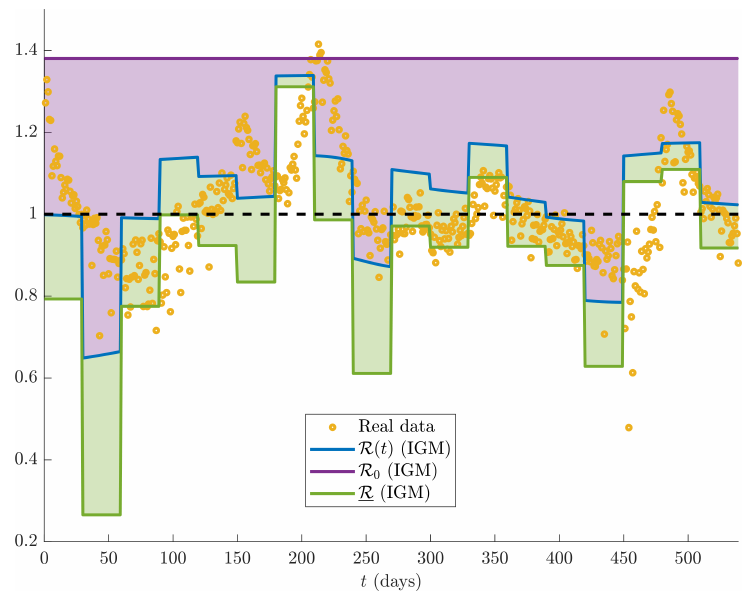
Figure 7. Evolution of the estimated time varying reproduction number R ( t ) , from real data (yellow circles) and IGM R ( t ) (blue line). The R 0 and R for IGM are reported in violet and green,